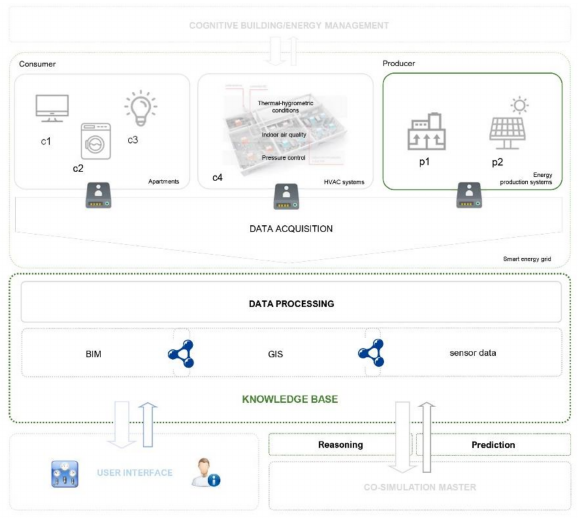
Figure 4. Data flow and processing for digital-twin-based energy